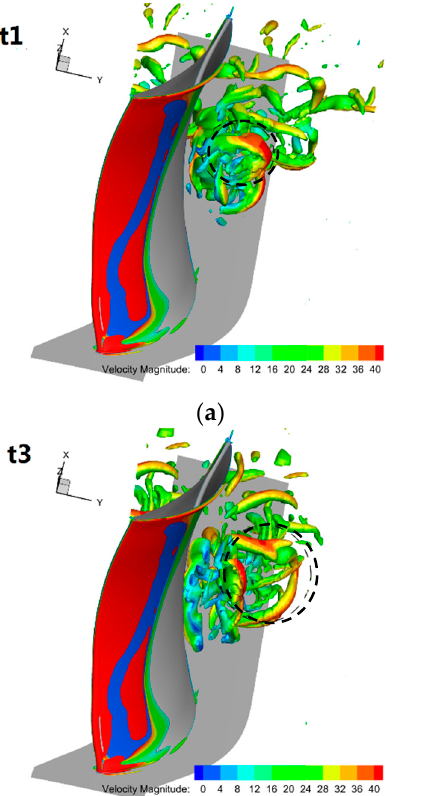
Figure 10. Isosurface of Q = 15,000,000.